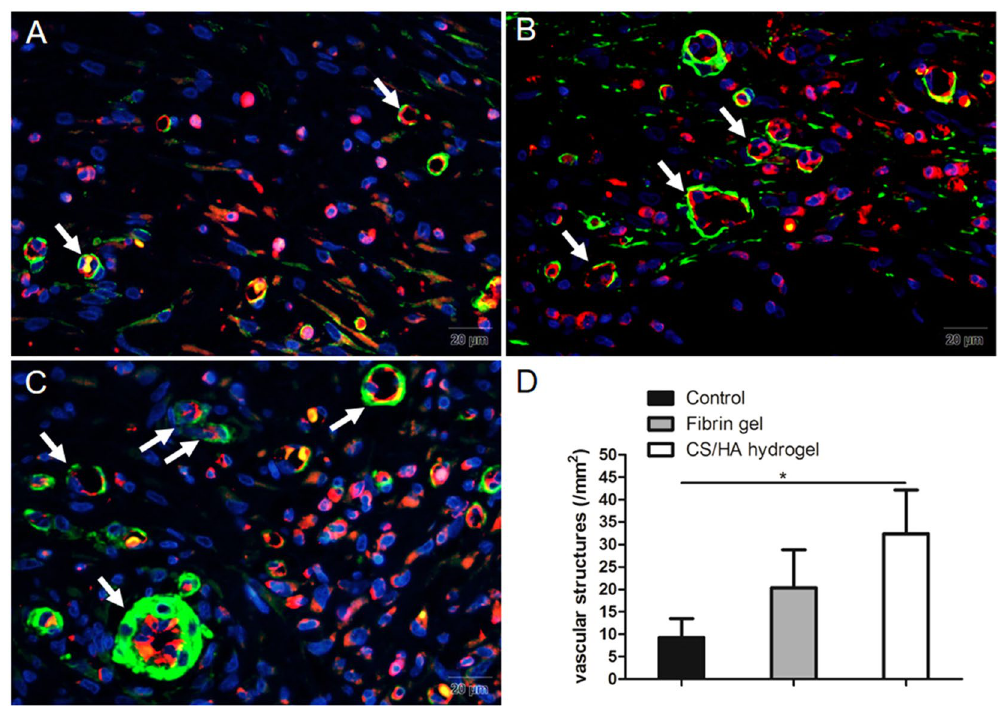
Figure 4. Neovascularization in different groups: ( A ) the Control; ( B ) Fibrin gel; ( C ) CS/HA hydrogel. The double staining revealed that CD31 ( + ) structures were surrounded by a-smooth muscle actin positive cells (indicated with white arrows). ( D ) Quantification of the CD31 labeled structures. Scale bar: 20 μ m. * P <